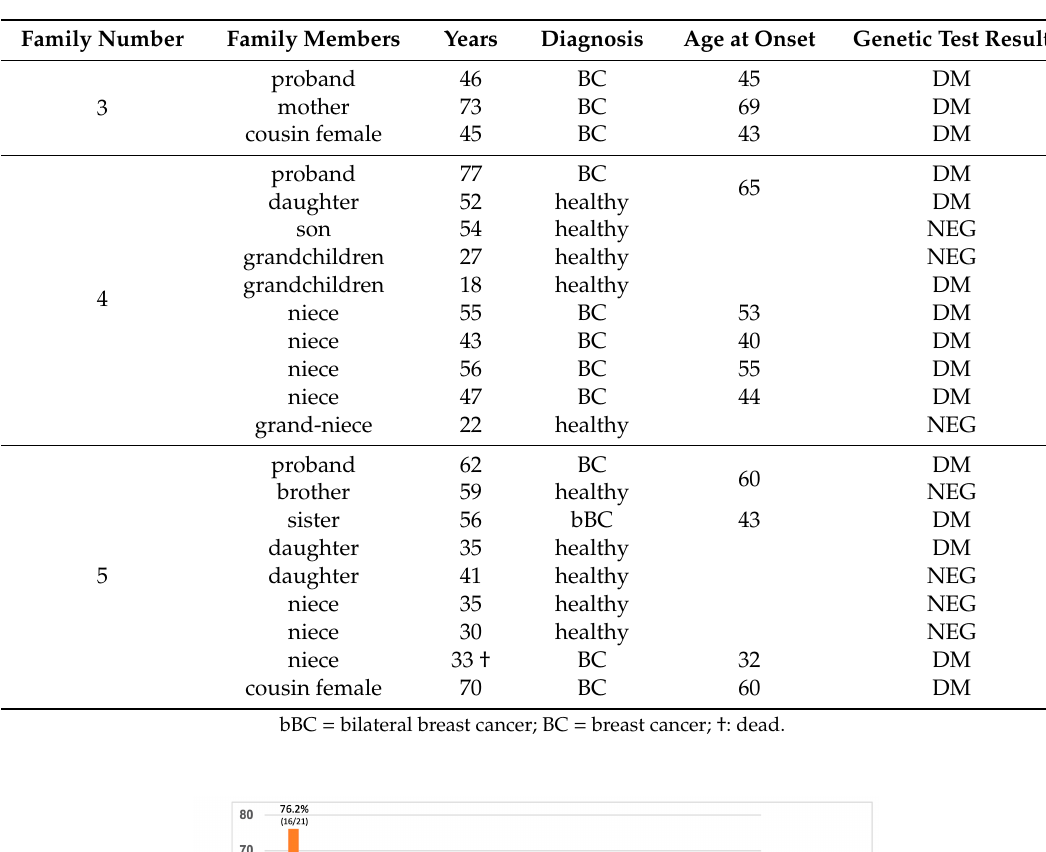
Table 4. Families tested for DM in BRCA2.